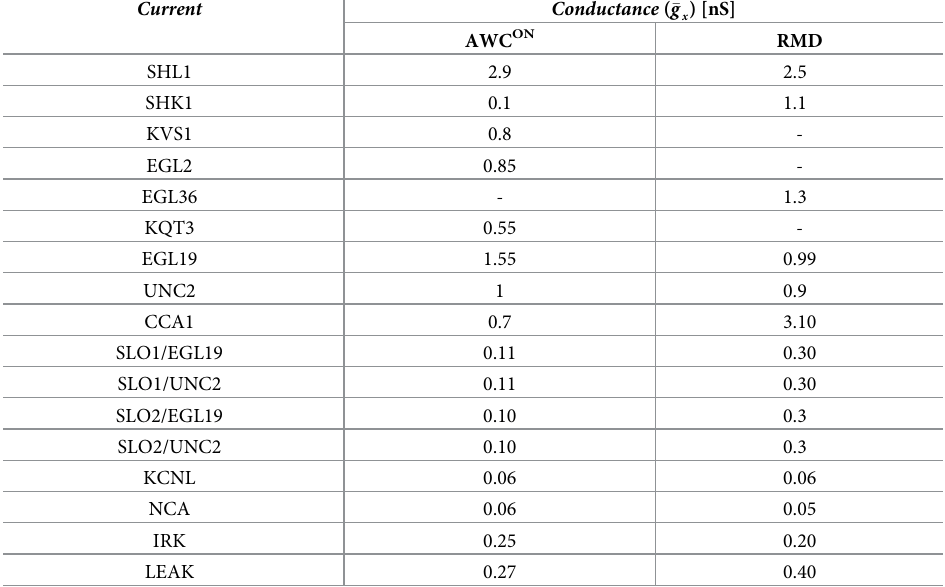
Table 2. Ionic conductances for AWC ON and RMD neurons. We use V K = − 80 mV, V Ca = 60 mV and V Na = 30 mV as the reversal potentials for potassium, calcium and sodium currents, respectively. In AWC ON the reversal potential for leakage current (Eq C10 in S1 File) is V = − 90 mV; in RMD it is V = − 80 L L